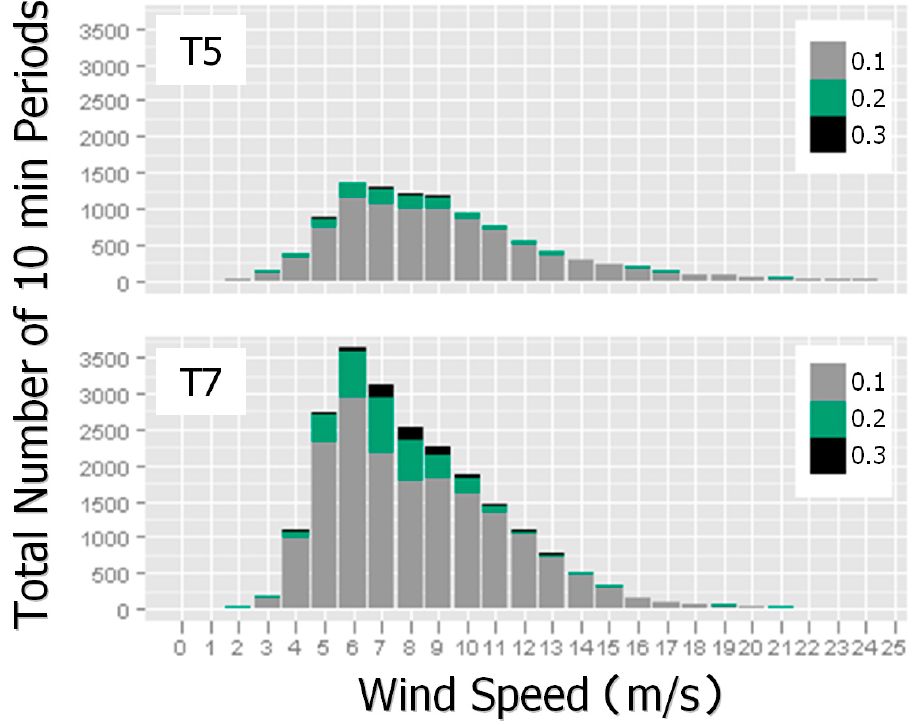
Figure 5. Comparison of the number of 10-min periods in which the TI of terrain-induced turbulence exceeded that for IEC turbulence class A at T5 and T7.